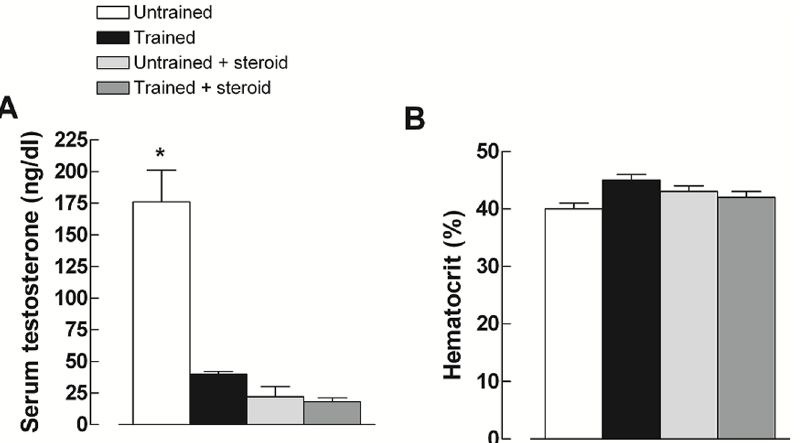
Figure 1. Blood sample biochemical analysis. Panel A: serum testosterone levels in ng/dl. Panel B: hematocrit percentage. Values are expressed at the mean 6 SEM for the control (C), low dose (LD) and high dose (HD). * represents significant differences (P , 0.05) with respect to other groups as determined by one-way ANOVA–Tukey test.